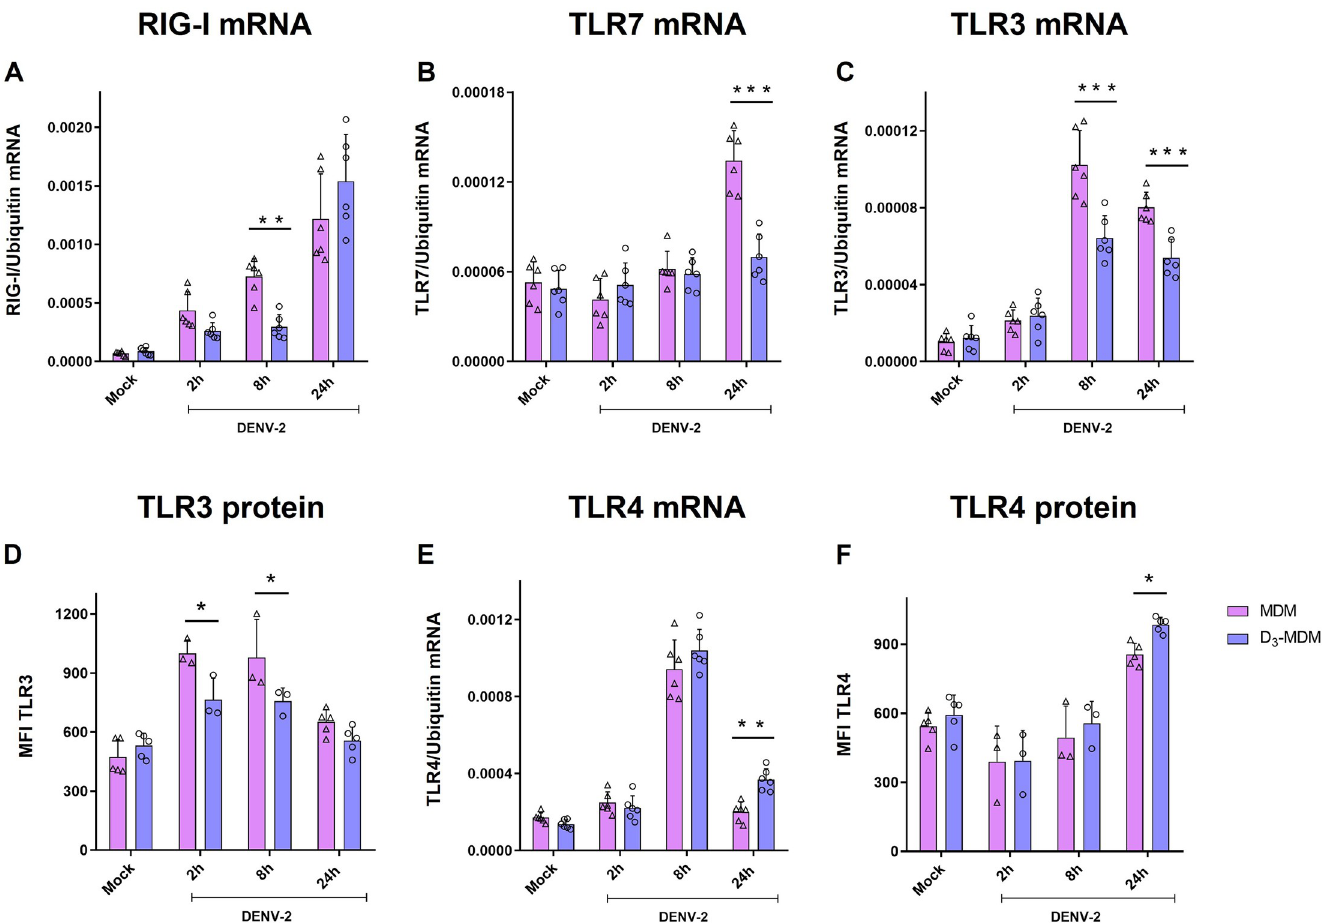
Fig 1. VitD3 modulates the expression of TLRs in D 3 -MDMs. The MDMs were differentiated in the presence of VitD3 (0.1 nM) for 6 days (D 3 -MDMs) and then infected with DENV-2 with an MOI of 5 for 2, 8, or 24 h. Expression of RIG I (A), TLR7 (B), TLR3 (C), and TLR4 (E) was measured by qPCR in MDMs and D 3 - MDMs using the gene encoding ubiquitin as a housekeeper gene. Data are expressed as fold change relative to mock-treated MDMs and D 3 -MDMs from each time point. Expression of TLR3 (D) and TLR4 (F) protein was measured by flow cytometry and expressed as mean fluorescence intensity. Six different donors were analyzed. Differences were identified using a two-way ANOVA with a Bonferroni posthoc test and a 95% confidence interval ( ��� p < 0.001, �� p < 0.01, � p < 0.05).